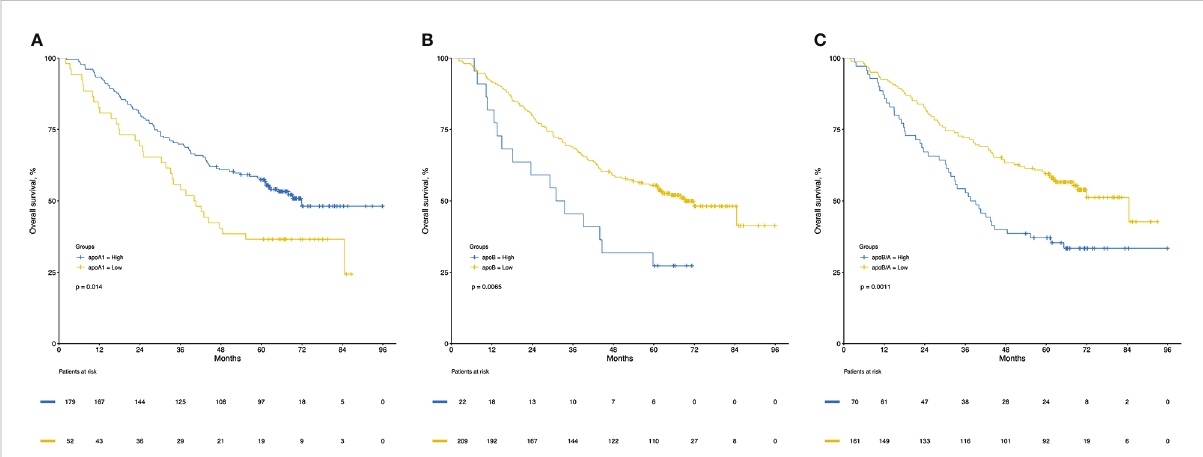
FIGURE 4 Kaplan-Meier curves of overall survival for apoA1 (A) , apoB (B) and apoB/A (C) . ApoA1, apolipoprotein A-I; apoB, apolipoprotein B; apoB/A, apolipoprotein B/apolipoprotein A-I.